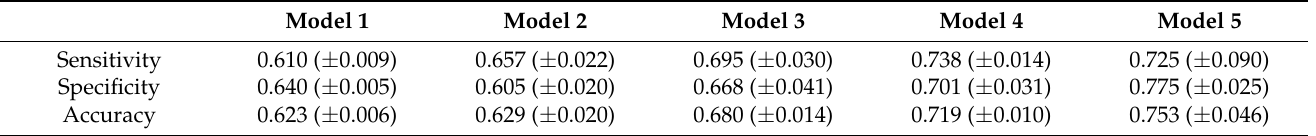
Table 9. Mean ± standard deviation of model performance parameters from fourfold cross-validation. Model 1 was trained on sensor data only; Model 2 included AMS data, animal, and farm information; for Model 3 AMS, animal and farm data were merged with sensor records; and Model 4 additionally included BCS data. In Model 5, the CPS was